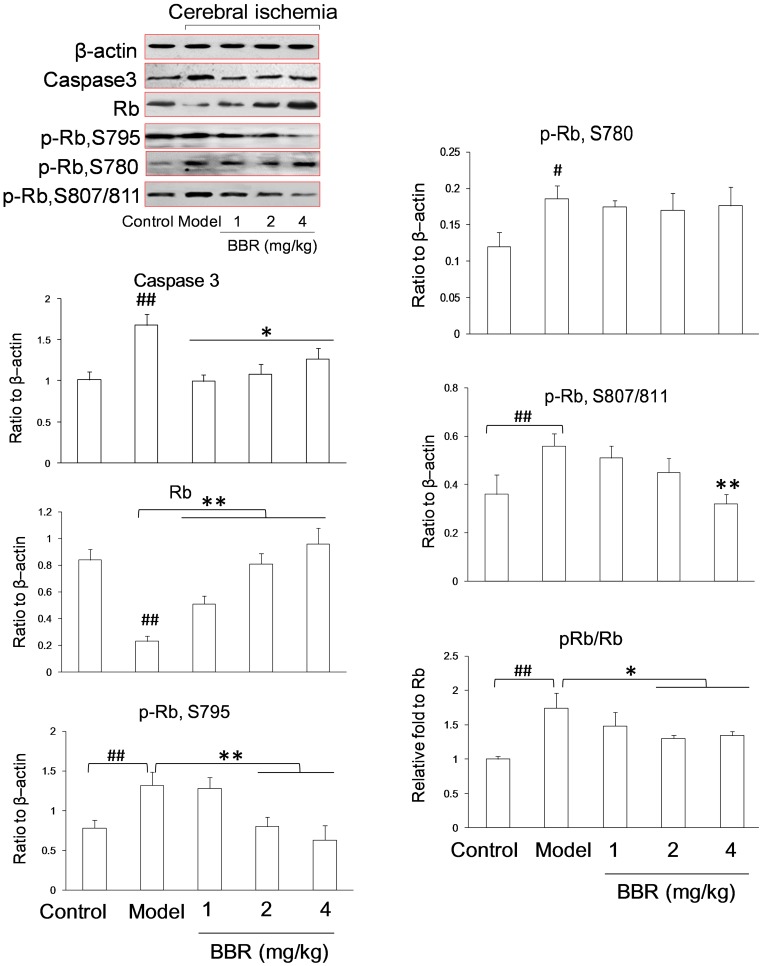
Expressions of Rb and phosphor-Rb (p-Rb) in the hippocampus of cerebral ischemia-treated mice as measured by Western blot.Berberine (BBR) was administrated by intraperitoneal injection with three different dosages (1, 2 and 4 mg/kg). Data are presented as mean ± S.D. of six mice (n = 6). ## P<0.01 v.s. control groups; *P<0.05, **P<0.01 v.s. model groups.